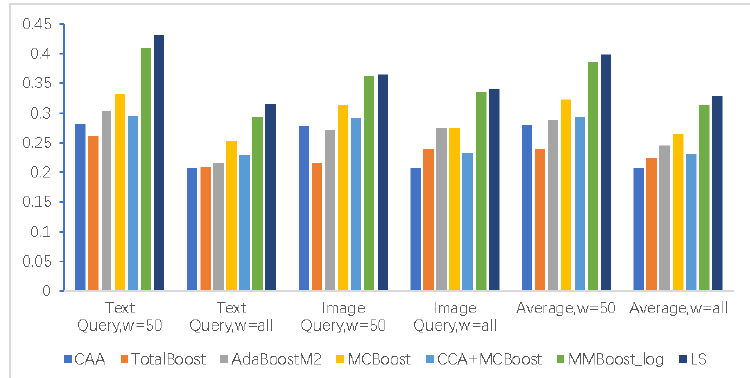
Figure 7. Performance comparison on the NUS-WIDE dataset.